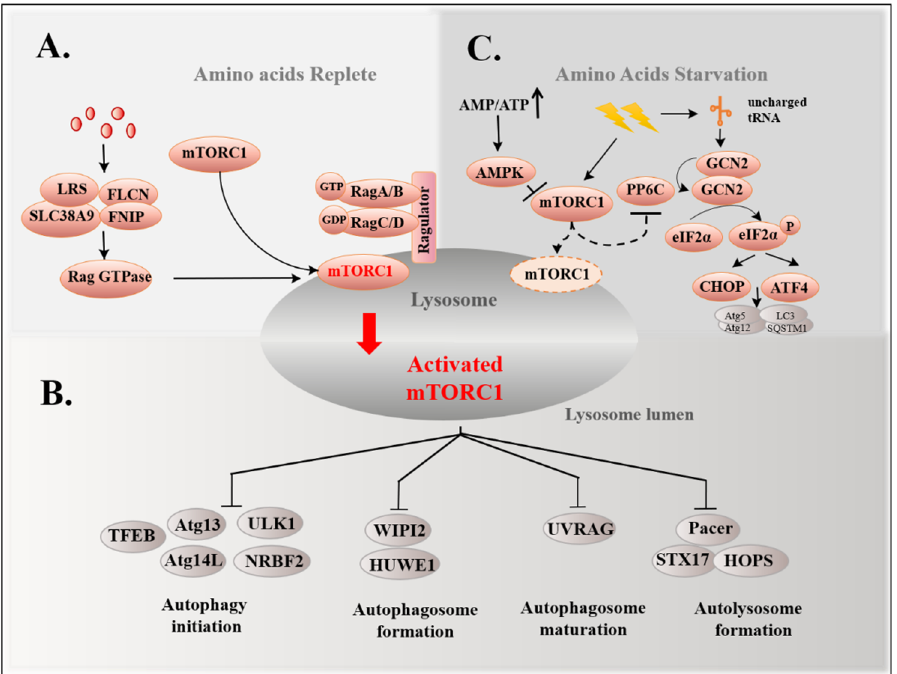
Figure 2. Classical amino acid sensing pathways regulate autophagy. ( A ) The abundant amino acids activate the Ragulator complex to promote the most active amino acid sensors, including SLC38A9, LRS, and FLCN-FNIP to RagGTPases, in which RagA/B binds to GTP and RagC/D to GDP, which recruits mTORC1 to the lysosome and is activated, thereby inhibiting autophagy. (The red arrow refers to the caption below, meaning the mTORC1 is activated in the lysosome.) ( B ) The mTORC1 activated by the abundant amino acids inhibits autophagy-related proteins, which are related with autophagy initiation, autophagosome formation, autophagosome maturation and autolysosome formation. ( C ) Amino acid starvation prevents the translocation of mTORC1 to the surface of the lysosome and inhibits its activity. GCN2 kinase binds to the elevated uncharged tRNA to be activated, then phosphorylates eIF2 α and upregulates the transcriptional activities of ATF4 and CHOP to induce autophagy.